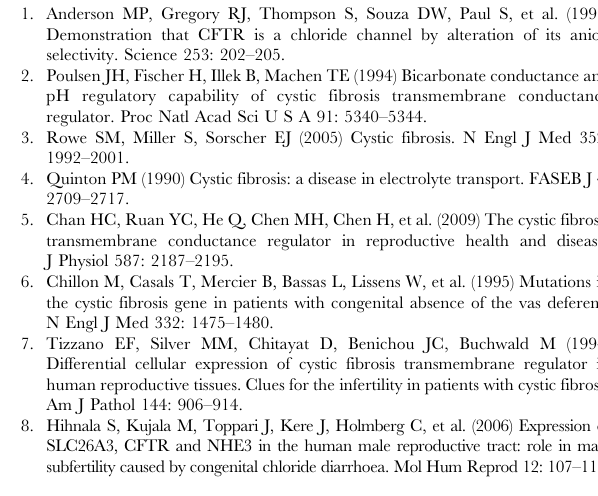
Figure S1 Enlarged image of spermatocytes and round spermatids of CF mice. Decreased size of spermatocytes and round spermatids in stage V–VI is observed in 2 / 2 testis compared to + / + and + / 2 . The cytoplasmic area of spermatocytes and round spermatids shrink progressively from + / 2 to 2 / 2 testes. P: pachytene spermatocytes, RS: round spermatids.